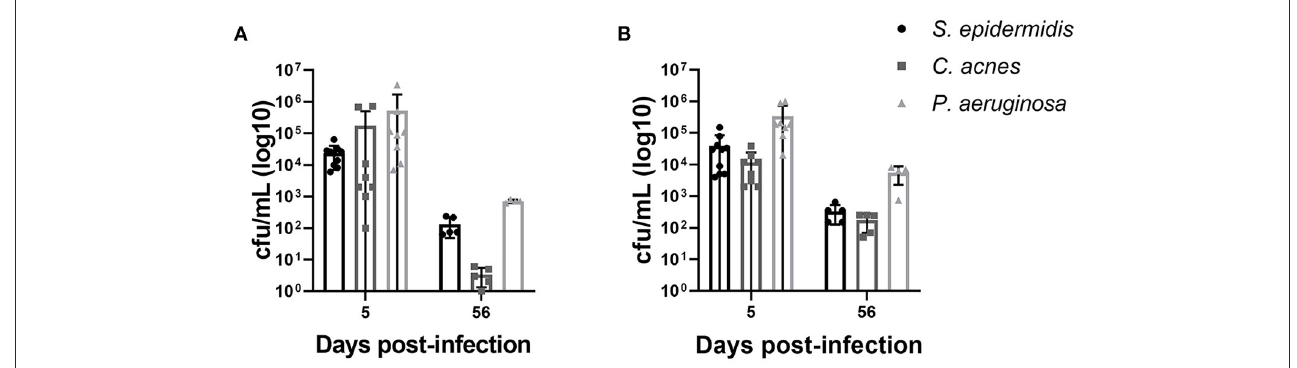
FIGURE1 Bacterial burdens from animals infected with S. epidermidis , C. acnes , and P. aeruginosa on catheters (A) and from surrounding brain tissue (B) . Statistical analysis was not performed as bacterial burdens were quantified to demonstrate active bacterial colonization and persistence. Sterile animals had no bacterial growth in either compartment at all time points and are not